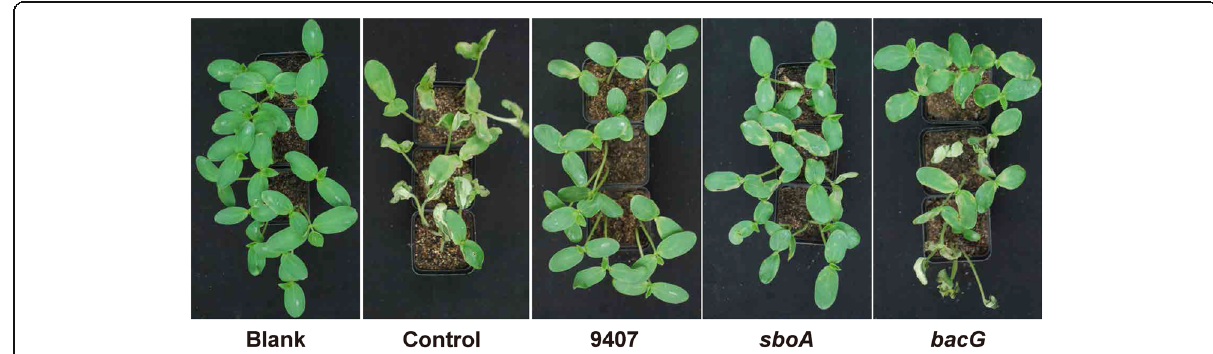
Fig. 6 Biocontrol efficacy of the sboA and bacG mutants against BFB under greenhouse conditions. Blank: PBS buffer was used to immerse the germinated melon seeds, and a saline solution (0.9% NaCl) was used to spray the seedlings; Control: PBS buffer was used to immerse the germinated seeds, and the seedlings were sprayed with A. citrulli ; 9407 : the germinated seeds were soaked in a suspension of B. subtilis 9407 and the seedlings were sprayed with A. citrulli ; sboA : the germinated seeds were soaked in the sboA mutant and the seedlings were sprayed with A. citrulli ; bacG : the germinated seeds were soaked in the bacG mutant and the seedlings were sprayed with A.